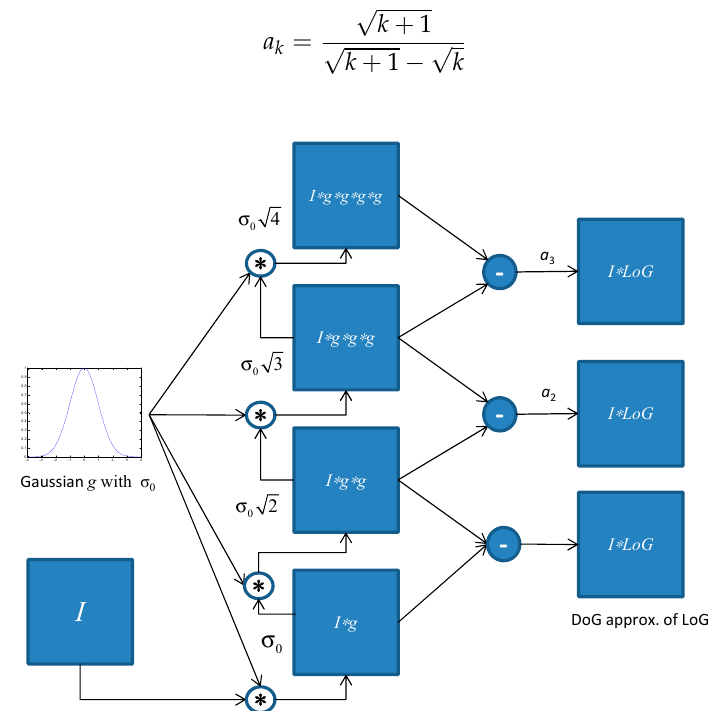
Figure 10. Schematic representation of the image response of the Gaussian kernel and the LoG, approximated as DoG, for increasingly values of σ .